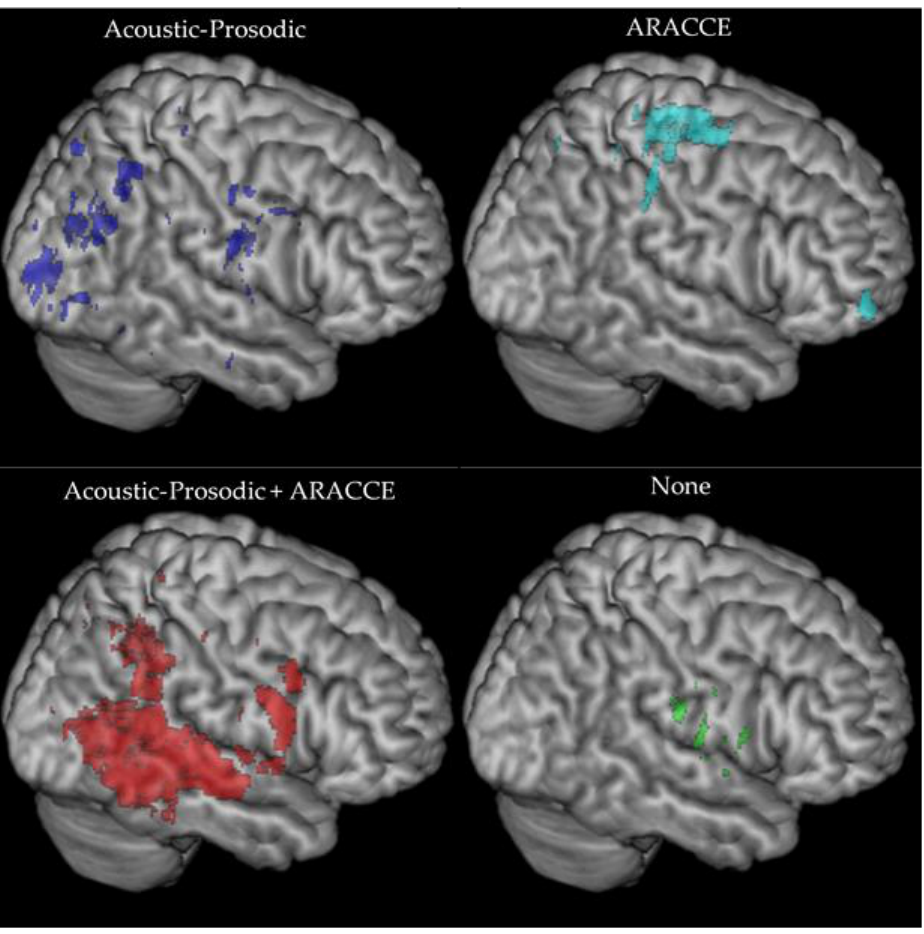
Figure 3. Lesion clusters for participants with receptive aprosodia characterized by acoustic-prosodic ( top left ), ARACCE ( top right ), acoustic-prosodic + ARACCE ( bottom left ), and no impairment loci ( bottom right ).